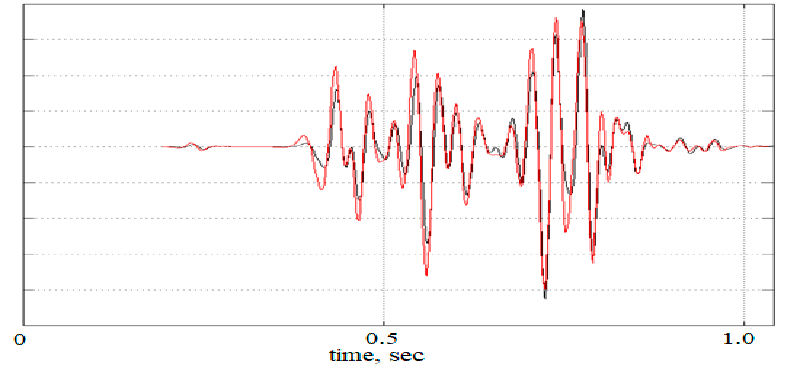
Figure 8. Comparison of a zero offset trace, computed by full finite difference simulation (black) and exploding reflectors approach (red).